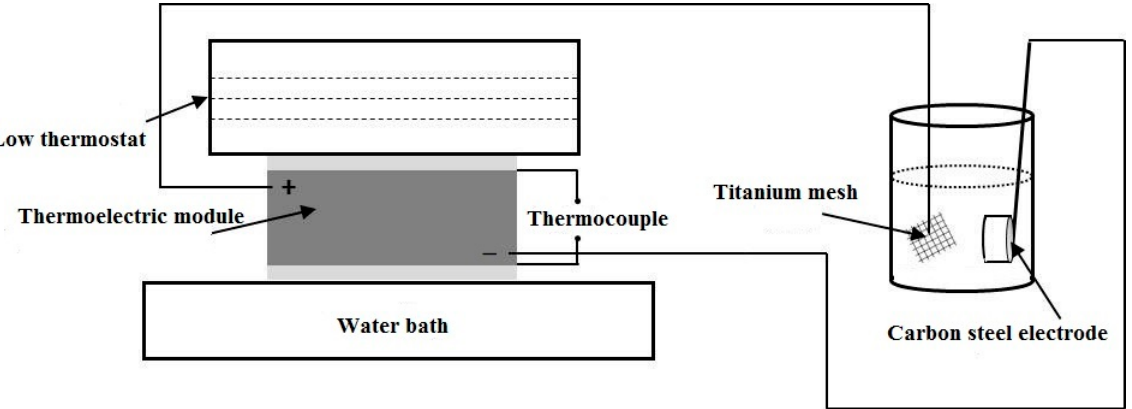
Figure 3. Schematic diagram of the cathodic protection system.